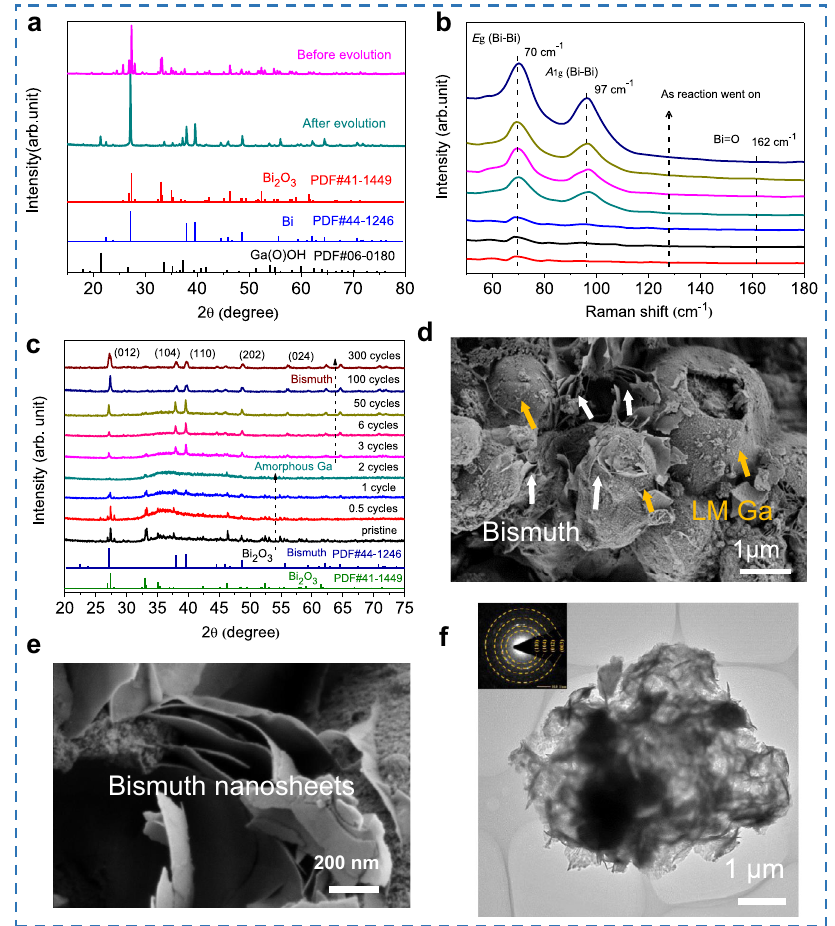
Fig. 2 | Composition and morphology characterizations of bismuth products before and after electrochemical evolution. a XRD patterns for raw material Bi 2 O 3 and the collected black products on the LM surface after CV diagnosis. b In situ Raman spectra for detecting the surface transformation of LM electrode as negative potential applied. c In situ XRD patterns for revealing the pathway and